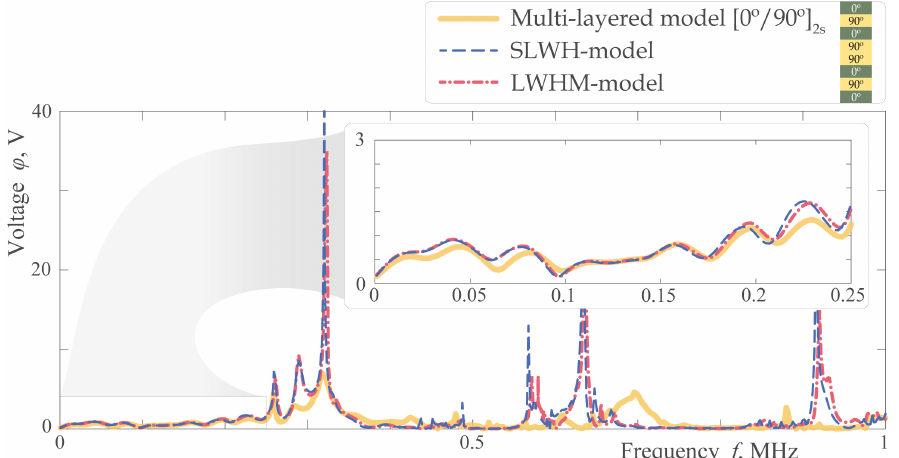
Figure 13. Voltage ¯ ϕ ( f ) measured at the sensor on the surface of multi-layered waveguide [ 0 ◦ ,90 ◦ ] 2s (thick solid line), and waveguides with effective properties estimated according to the SLWH-model (thin solid line) and the LWHM-model (dash-dotted line).